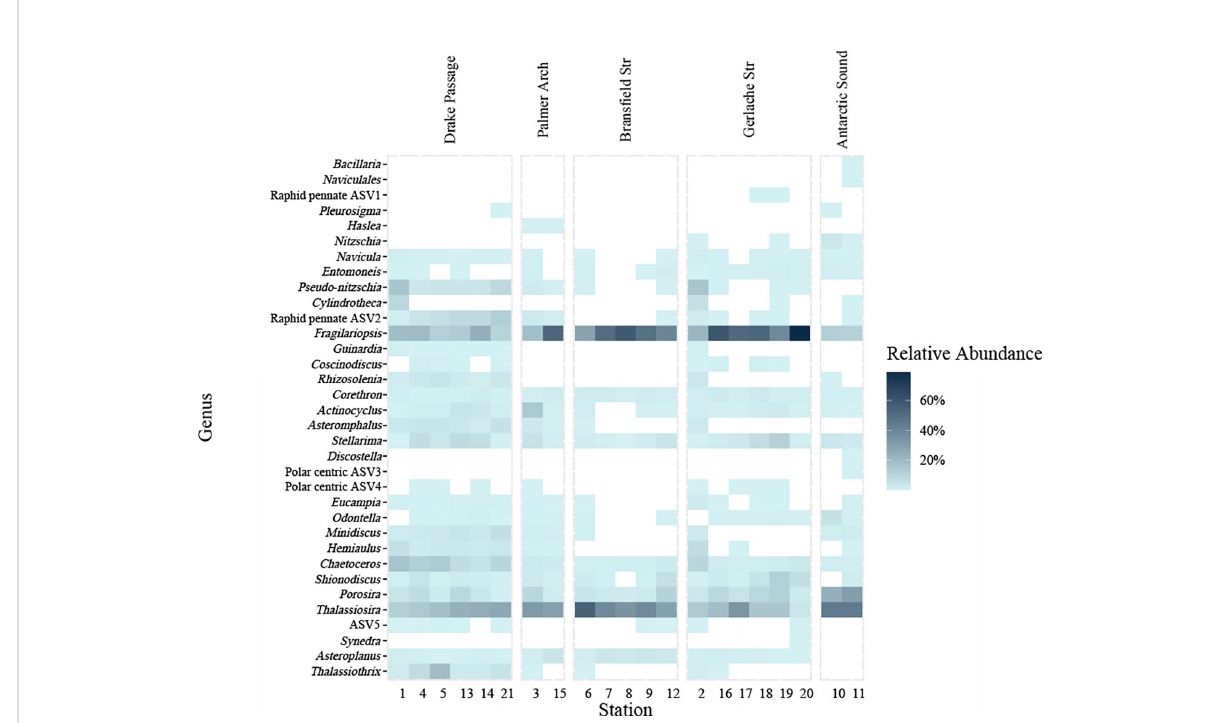
FIGURE 3 Diatom genera present at stations (bottom) sampled grouped by general location (top) from NBP16-08 from % relative abundance of the sequencing reads of the 18S V4 rDNA barcoding from the total sequencing reads identi fi ed as diatoms. A white box denotes that the genus was absent. Amplicon sequence variants (ASVs) that were identi fi ed as the same genus are grouped together. Any ASVs not identi fi ed to the genus level were retained separately and labeled as their lowest taxonomic assignment. Genera are ordered by family, with raphid pennates at the top from Bacillaria spp. – Fragilariopsis spp. including two unknown genera, radial centric basal Coscinodiscophyceae from Guinardia spp. – Stellarima spp., polar centric Mediophyceae from Discostella spp. – Thalassiosira spp. including two unknown genera, and lastly araphid pennates from Synedra spp. – Thalassiothrix spp. One ASV labeled as ASV5 was not identi fi ed at the family level (above Syndedra